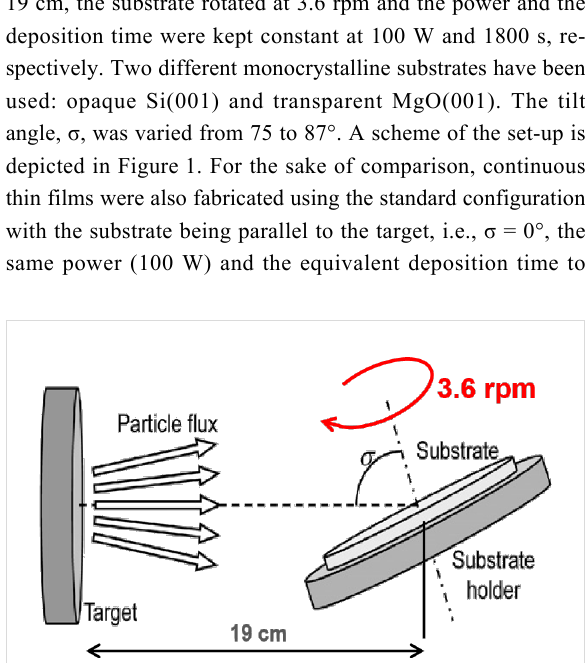
Consequently, from an industrial point of view, sputtering is the best